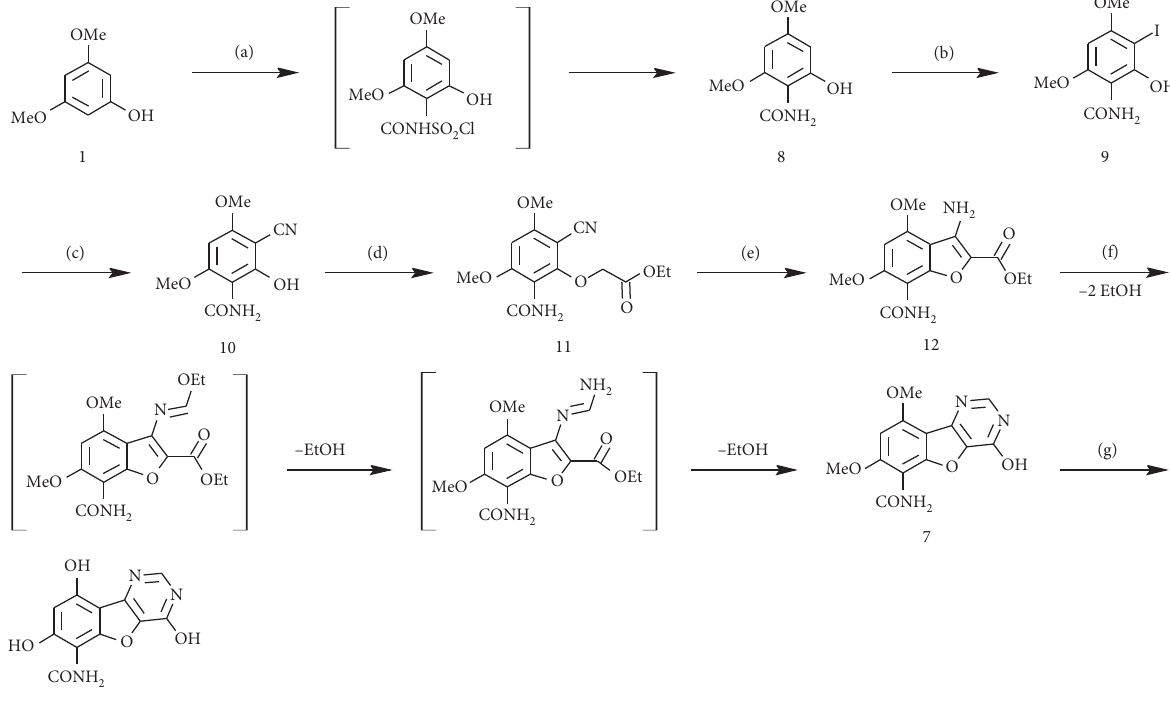
Figure 3: (a) CSI, CH ° C, 10 min and then HCl 5 M, rt, 10h, 45%. (b) NIS, CH 3 CN, 0 (d) NaH, BrCH 2 CO 2 Et, DMF, rt, 24h, 90%. (e) NaH, DMF, 0 ° C, 10 min, 67%. (f) HC (OEt) 3 , MW, 200 ° C, 15min and then NH 3 /MeOH 7N, MW, 140 ° C, 15min, 62%. (g) Pyridine. HCl, MW, 200 ° C, 10min, 43%.